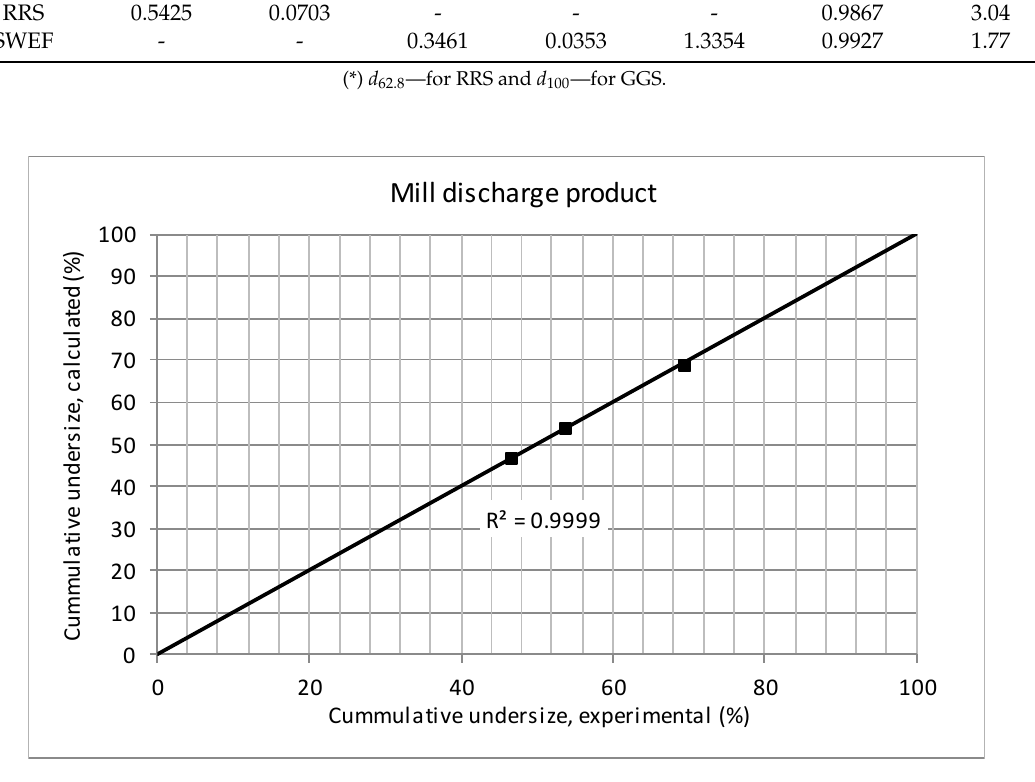
Figure 4. Zero error graph for the mill discharge.